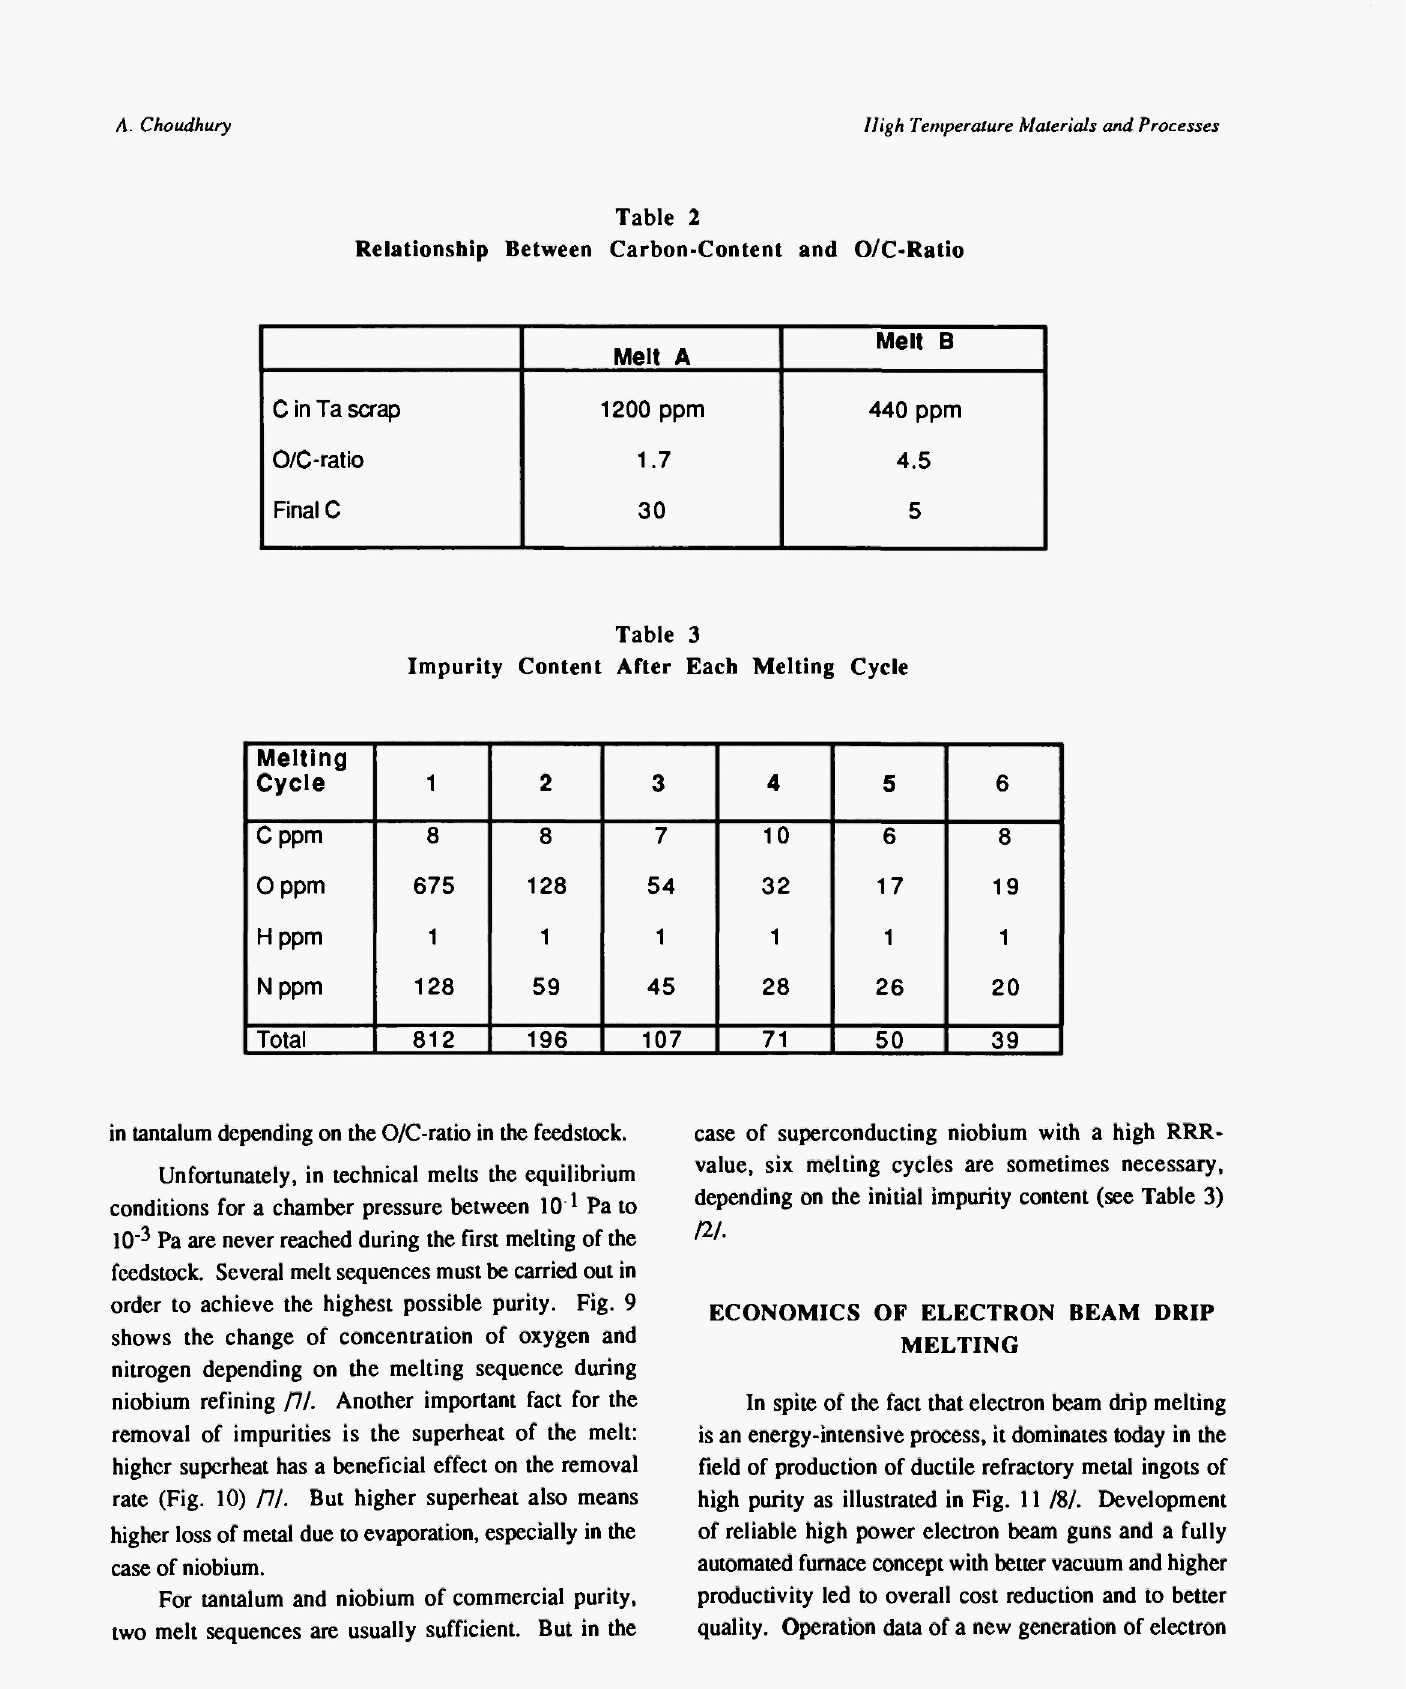
Relationship Between Carbon-Content and O/C-Ratio